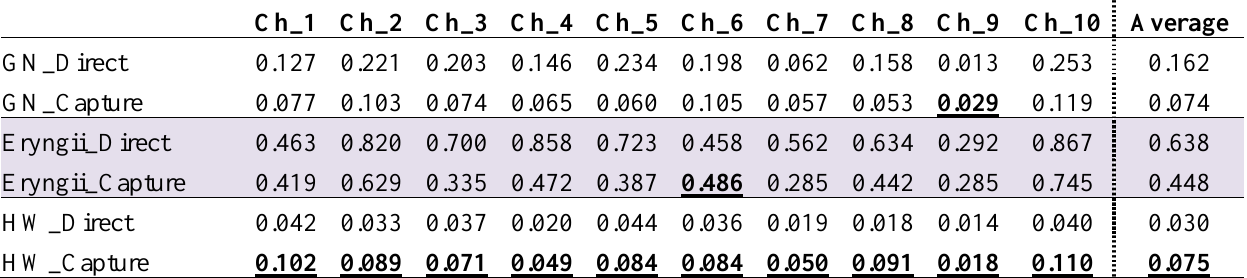
Table 2. Coefficient of Variation (C.V.) in direct mode and capture mode (n =